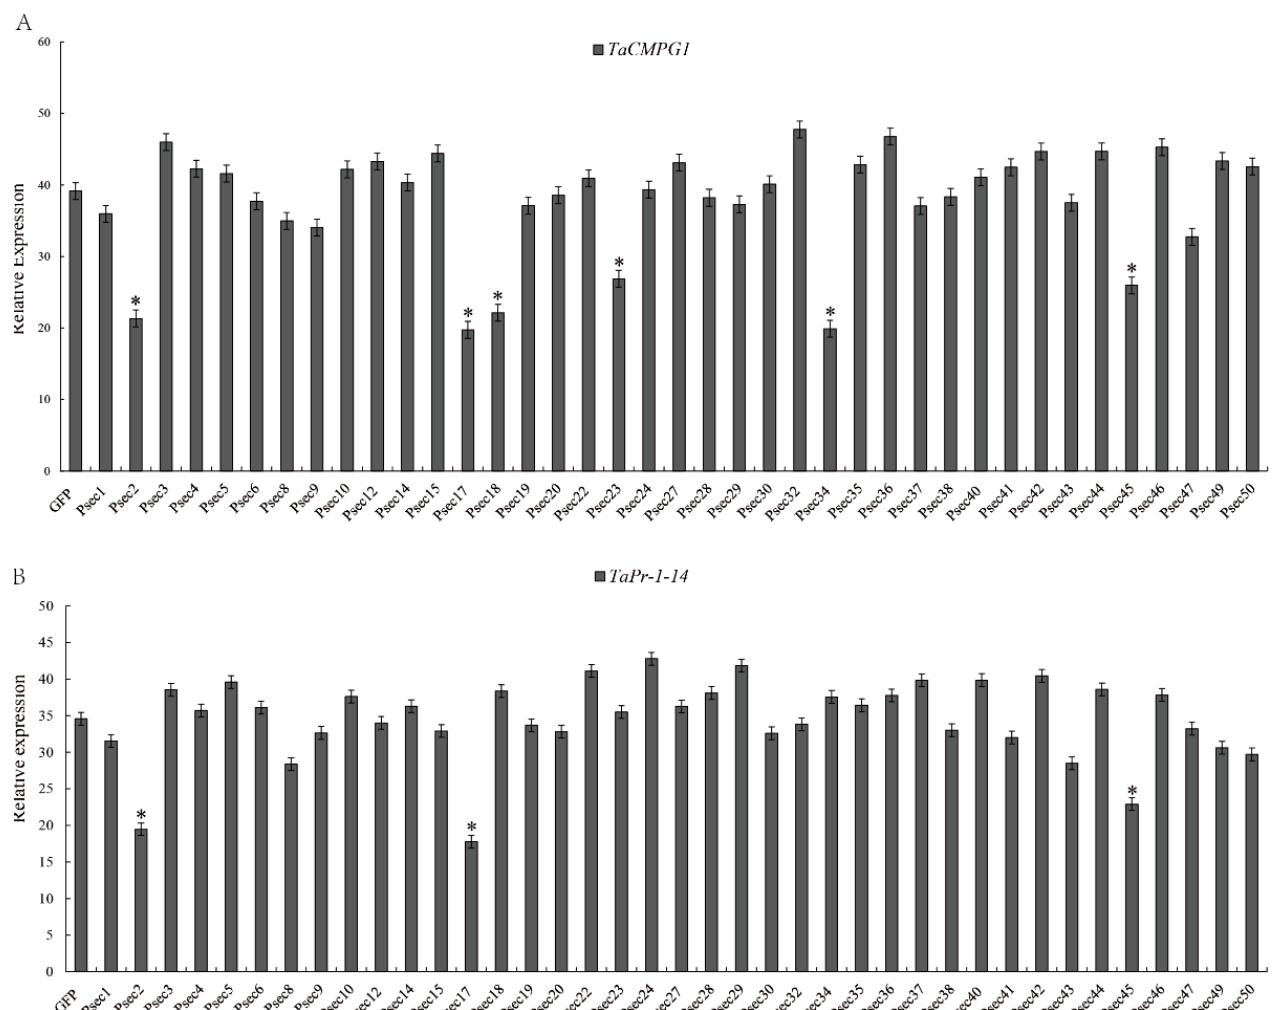
Figure 7. Screening of candidate effectors of stripe rust by the marker gene TaCMPG1 ( A ) and TaPr-1-14 ( B ). Wheat protoplasts were isolated from wheat cultivar CN19. Expressing GFP and candidate effectors were treated with chitin for 4h. The relative expression of TaCMPG1 and TaPr-1-14 was determined by qRT-PCR. The induction fold of TaCMPG1 and TaPr-1-14 was calculated by the gene expression level in chitin-treated protoplasts relative to that in H 2 O-treated protoplasts at the same time point. Bars represent standard deviations (SD), which were calculated from four independent biological replicates ( n = 4). Asterisks indicate significant differences calculated using Student’s t -test. (* p < 0.05).